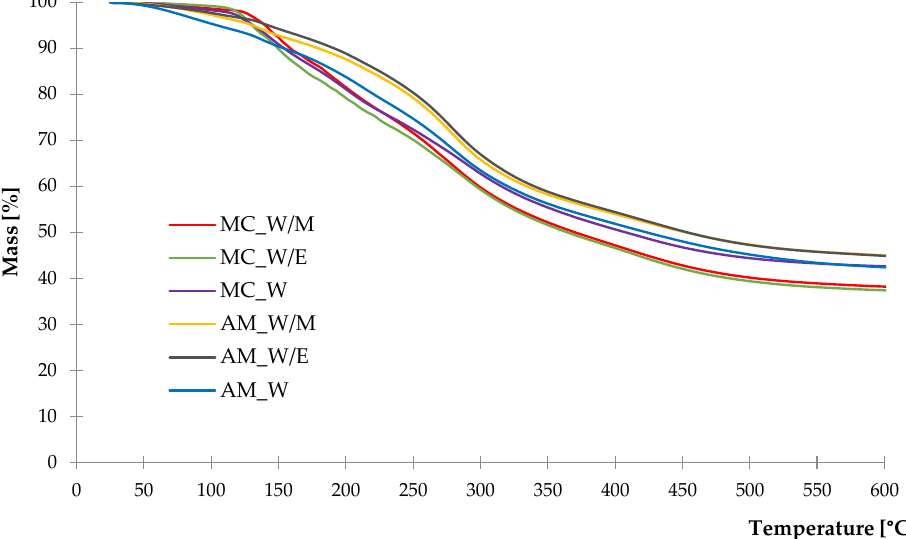
Figure 5. TG curves of freeze-dried extracts.